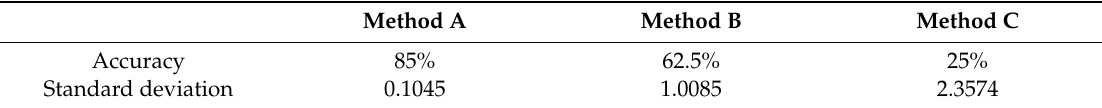
Table 5. Results of comparative experiments based on SAE.